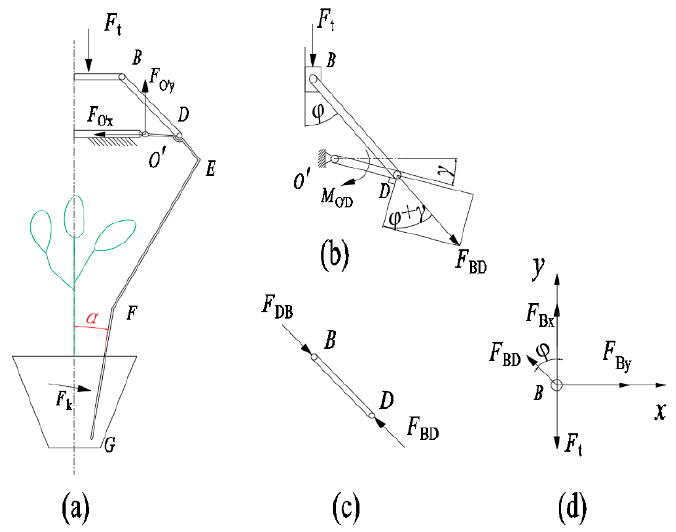
Figure 5. Force analysis diagram of seedling pick-up manipulator mechanism. ( a ) First inserting and then clamping, diagonally clipped. ( b ) First inserting and then clamping, four-edge clipped. ( c ) Inserting while clamping, diagonally clipped. ( d ) Inserting while clamping, four-edge clipped. The instantaneous force of the clamping pot by the seedling-taking manipulator is as shown in Figure 5a. The constraint between the O (cid:48) point and the fixed plate is a hinge. The binding force at O (cid:48) can be decomposed into orthogonal components F reaction force of the clamping finger end segment F G on the pot. The equilibrium